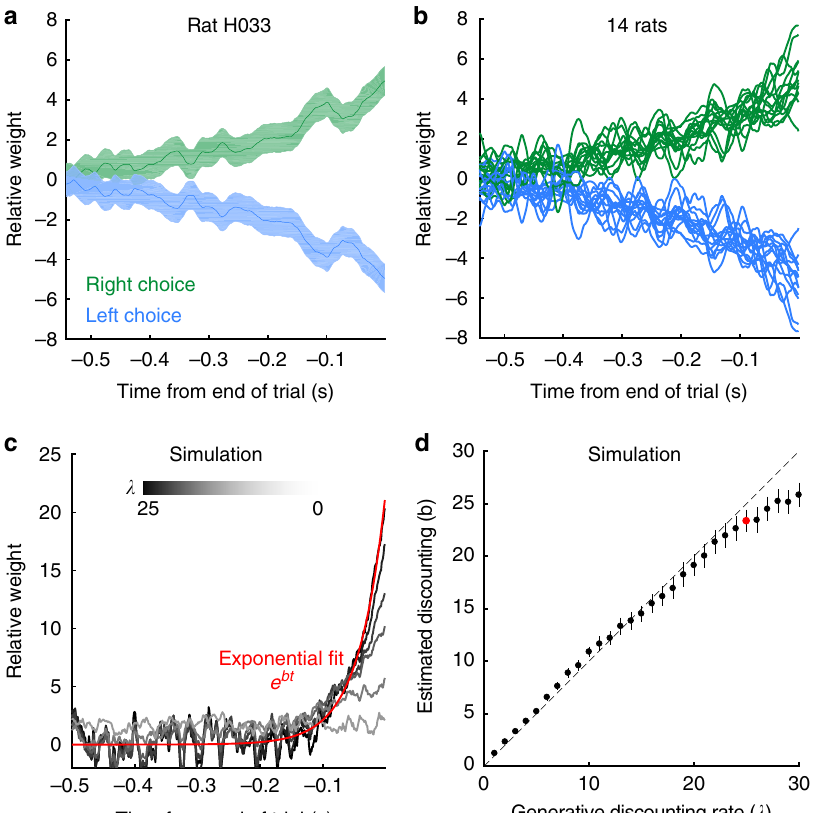
Fig. 3 Rats discount evidence. a Reverse correlation curves for an example rat reveals how clicks at each time point in fl uence the rat ’ s decision. Error bars show standard deviation. b Reverse correlation curves for 14 rats. Error bars are omitted for clarity. c Reverse correlation curves for a range of simulated linear discounting agents. Black to white lines indicate increasing discounting rates ( λ ). Only the reverse correlation curve for the right choice are shown for clarity. Each curve was fi t with an exponential function (example red). The fi t parameters are used in ( d ). d Exponential fi t to each discounting agent recovers the generative linear discounting rate. Example in ( c ) show with red dot. Error bars show 95% con fi dence intervals of exponential fi t